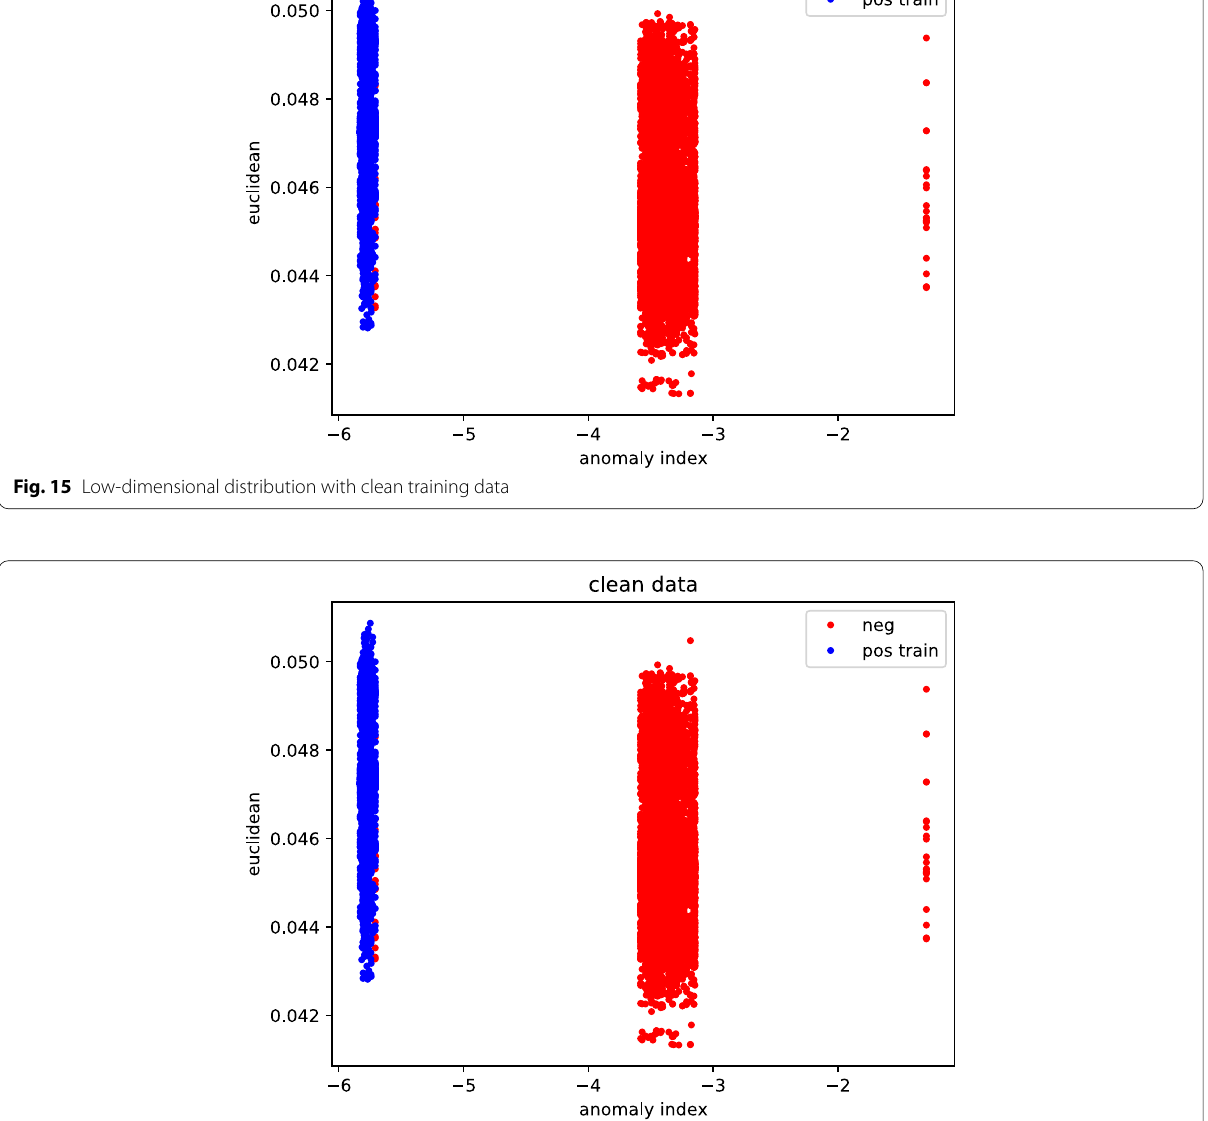
Fig. 16 Low-dimensional distribution with dirty